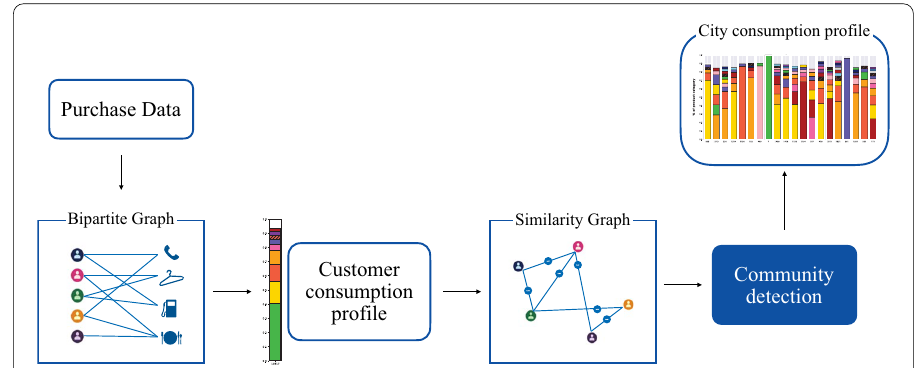
Fig. 1 Methodology pipeline: A summary of the pipeline to extract and analyze the city consumption profiles. The transformation and analysis pipeline moves from left to right; from the raw purchase data, we build a bipartite graph (customer-to-merchant category). From the bipartite graph, we derive a customer consumption profile, which summarizes the single spending behavior of clients. The customer consumption profiles are nodes of a similarity graph where edges connect very similar consumption profiles. As the last step, a community detection algorithm, run on the similarity graph, identifies the representative consumption profiles used to obtain the city consumption